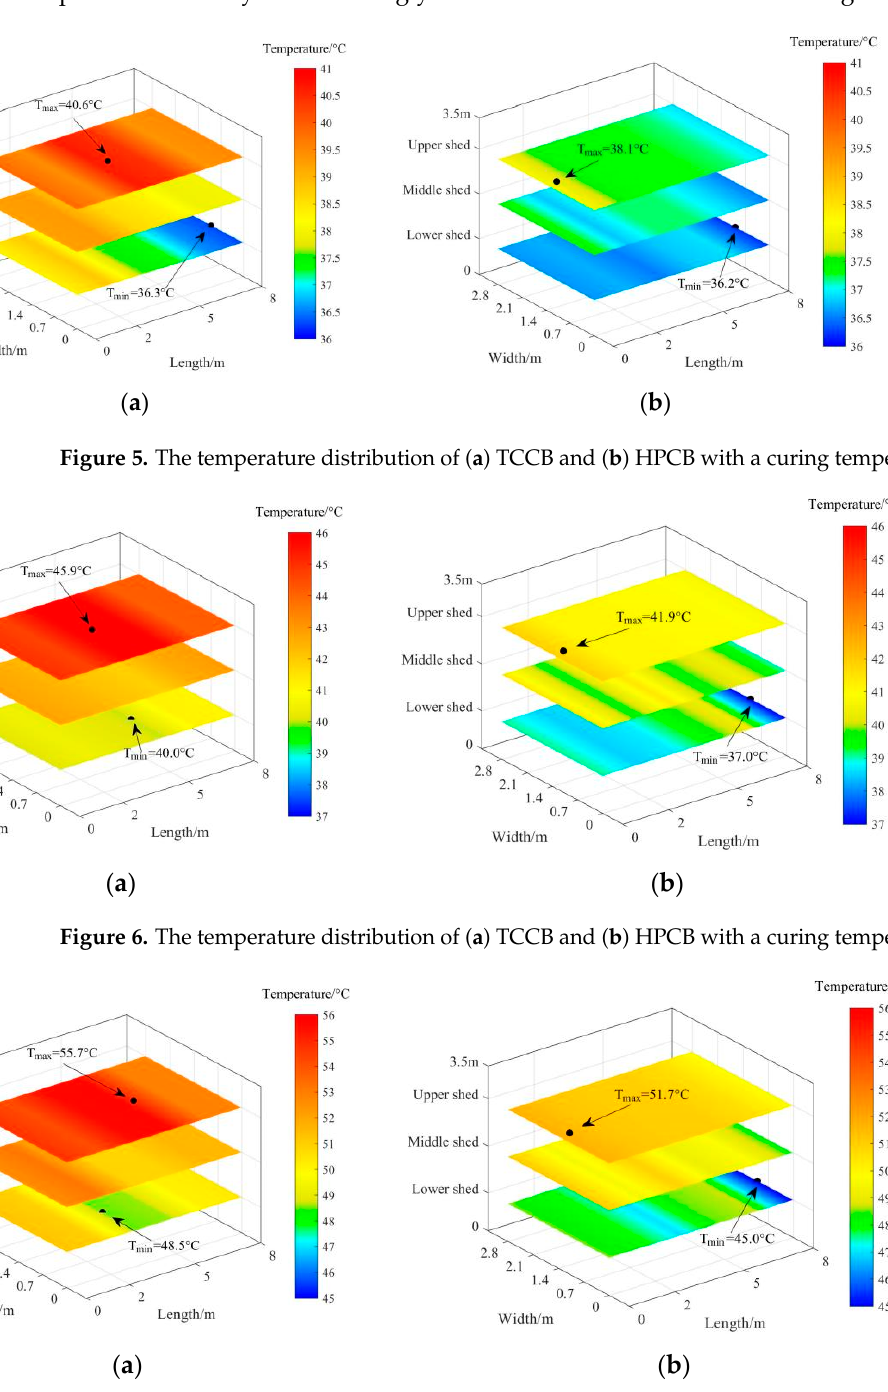
Figure 7. The temperature distribution of ( a ) TCCB and ( b ) HPCB with a curing temperature of 50 °C.